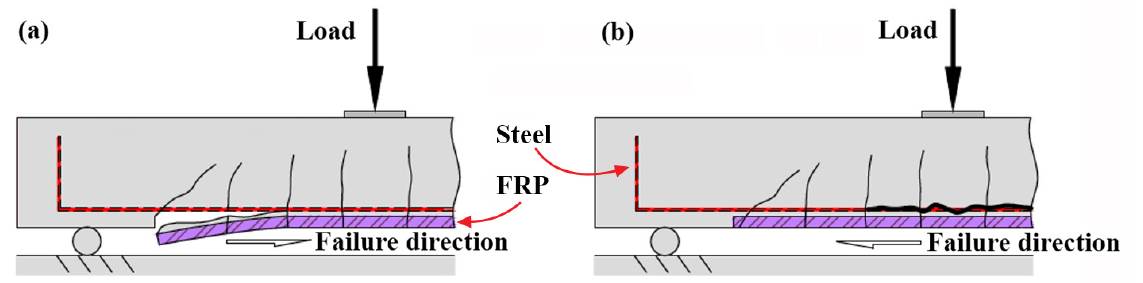
Figure 1. Location of concrete cover separation occurring at FRP-strengthened RC beams: ( a ) FRP reinforcement end; and ( b ) the maximum moment region.